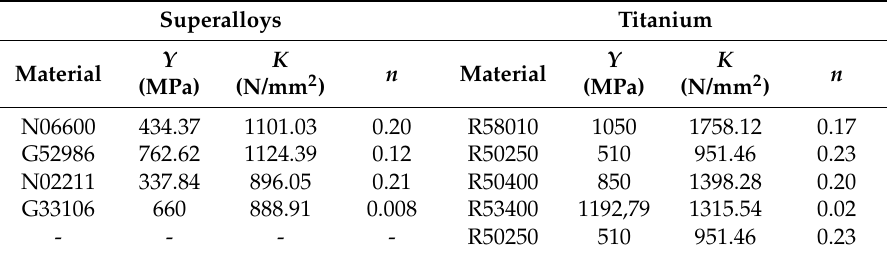
Table 2. Titanium and superalloys characteristics. UNS codification.